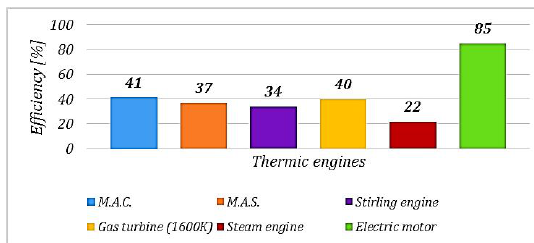
including transport, is 29.3%. The same calculation made for coal has an overall efficiency of 31.1%. In this case, the electric engine powered by oil-source energy is 24.9%, and powered by coal-source energy is 26.4%